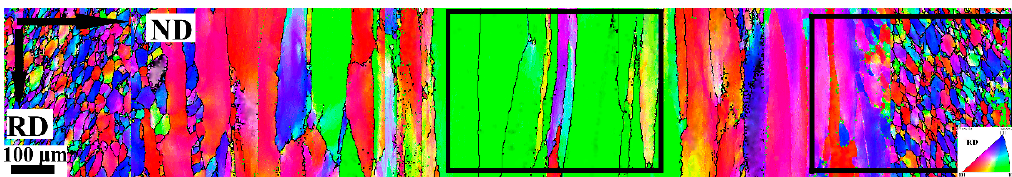
Figure 1. Orientation imaging of the hot-rolled sheet. A color-coded map referred to the rolling direction is shown on the lower right side. (RD: rolling direction; ND: normal direction of the rolled plane).